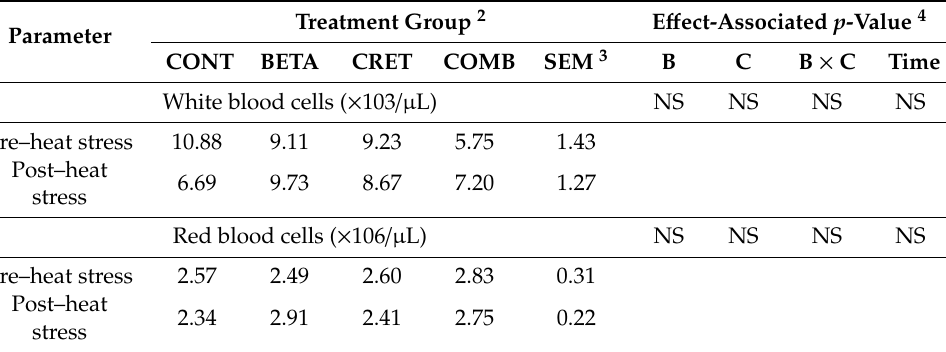
Table 4. Means of blood parameters in broiler chicks 1 treated with dietary betaine (B) and / or creatine (C) and experiencing acute heat